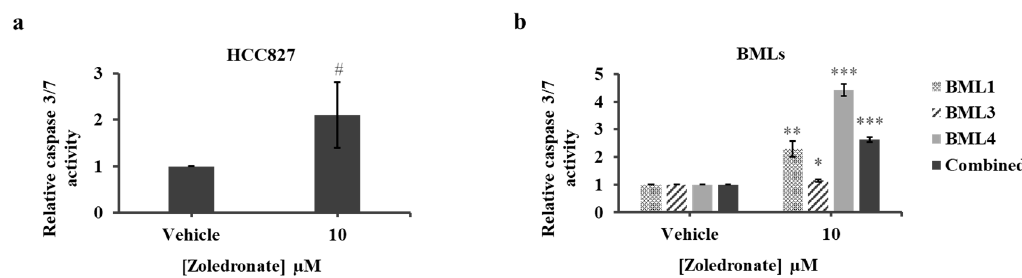
Figure 4. Caspase 3 / 7 activity assay of HCC827 ( a ) and lung cancer-induced bone metastasis cells ( b ) cells treated with vehicle (PBS1x) or Zol 10 µ M for 7 days in 1% serum conditions. The histograms represent the ratio of drug-treated cells divided by vehicle-treated cells (PBS1x). Results are the mean ± SD of three independent experiments for HCC827 and bone metastasis cells. Marginally significant # p ≥ 0.05 and significantly different from control, * p < 0.05, ** p < 0.01 and *** p < 0.001.